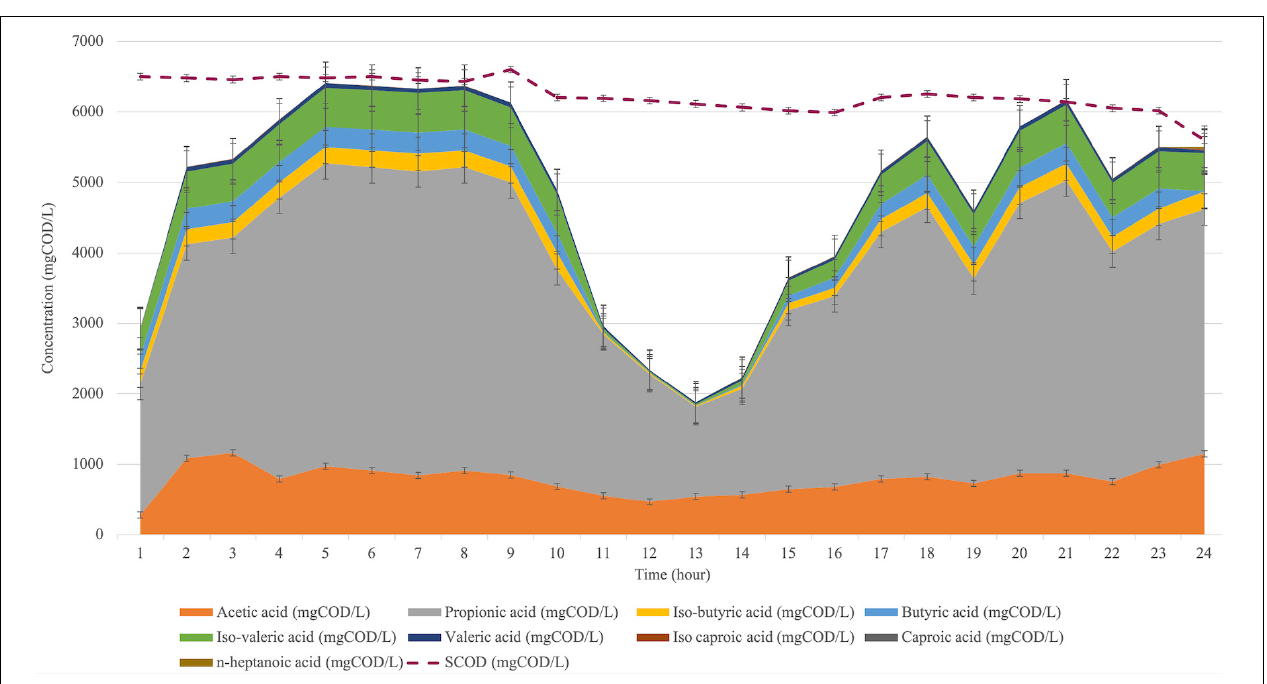
FIGURE 5 | VFA composition shift during a cycle analysis at the bioaugmented reactor for 24